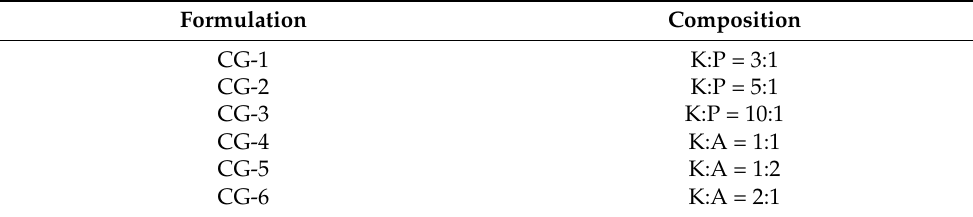
Table 3. Formulations of Co-grinded